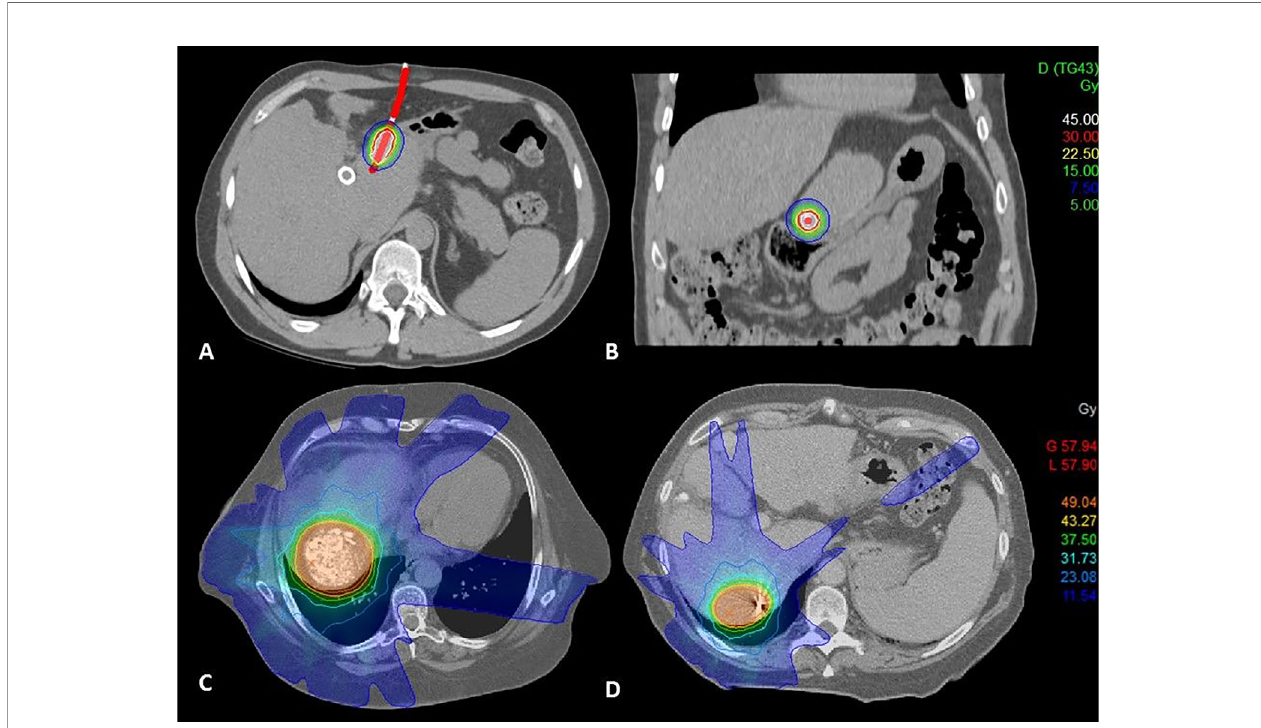
FIGURE 1 | (A) Brachytherapy dose distribution coronal view, (B) Brachytherapy dose distribution sagittal view, lesion in close proximity to the stomach, (C) SBRT dose distribution, treatment following TACE, (D) SBRT dose distribution lesion with fi ducial